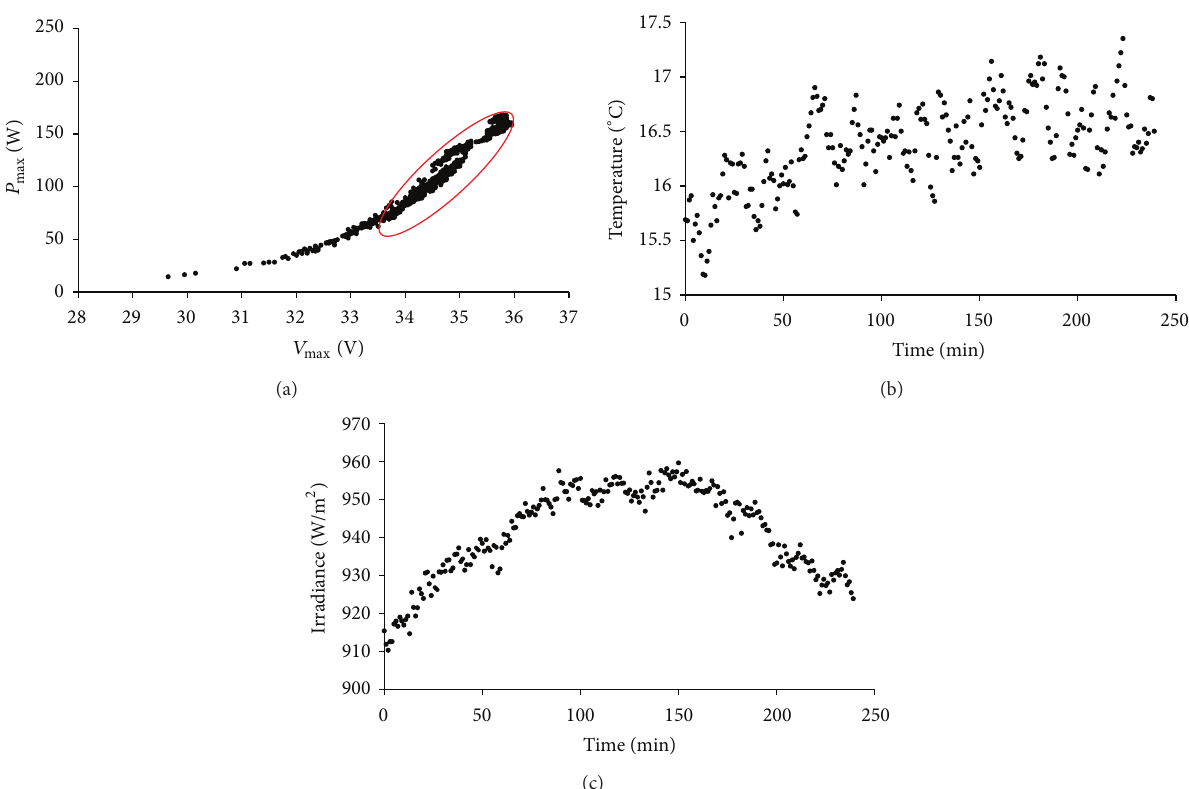
Figure 11: (a) The definition of hitting zone for the experiment using real weather data, (b) the real temperature data recorded in 04/01/2014 and used for generating the test data, and (c) the real irradiance data recorded at 04/01/2014 and used for generating the test